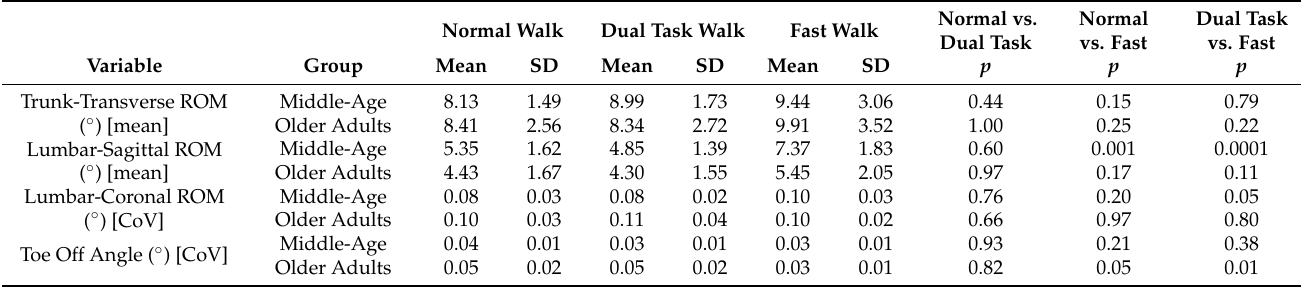
Table A3. Condition by Group post-hoc for gait variables demonstrating a significant interaction between Middle-aged Adults and Older Adults. ROM—range of motion, CoV—Coefficient of Variation, p —post-hoc significance.